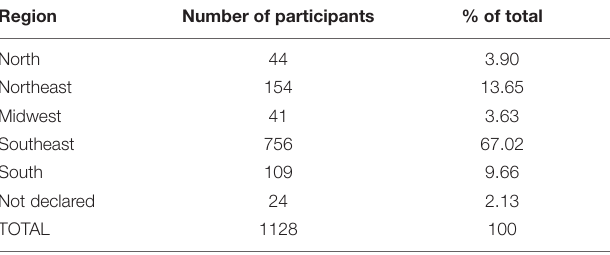
TABLE 1 | Number of participants in each region and percent of total.